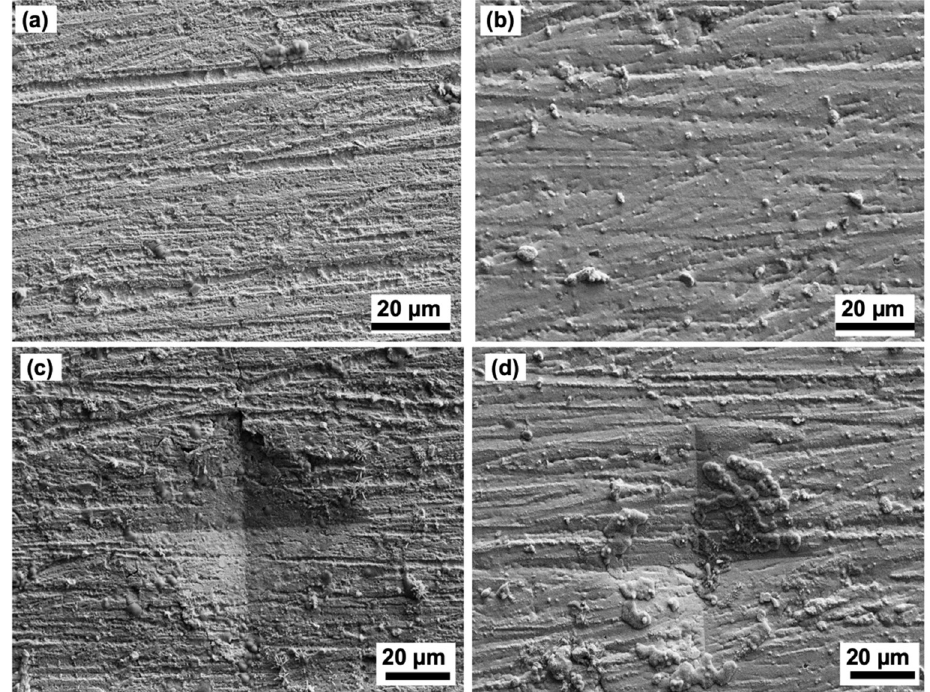
Figure 10. FESEM micrographs of the non-indented and indented surfaces after 12-week storage at 30 °C/60% RH with various coatings of Sn/Ni layer: ( a ) Non-indented, Sn/Ni = 1.5/2.4 µm, ( b ) non-indented, Sn/Ni = 1.5/2.7 µm, ( c ) indented, Sn/Ni = 1.5/2.4 µm, and ( d ) indented, Sn/Ni = 1.5/2.7 µm.